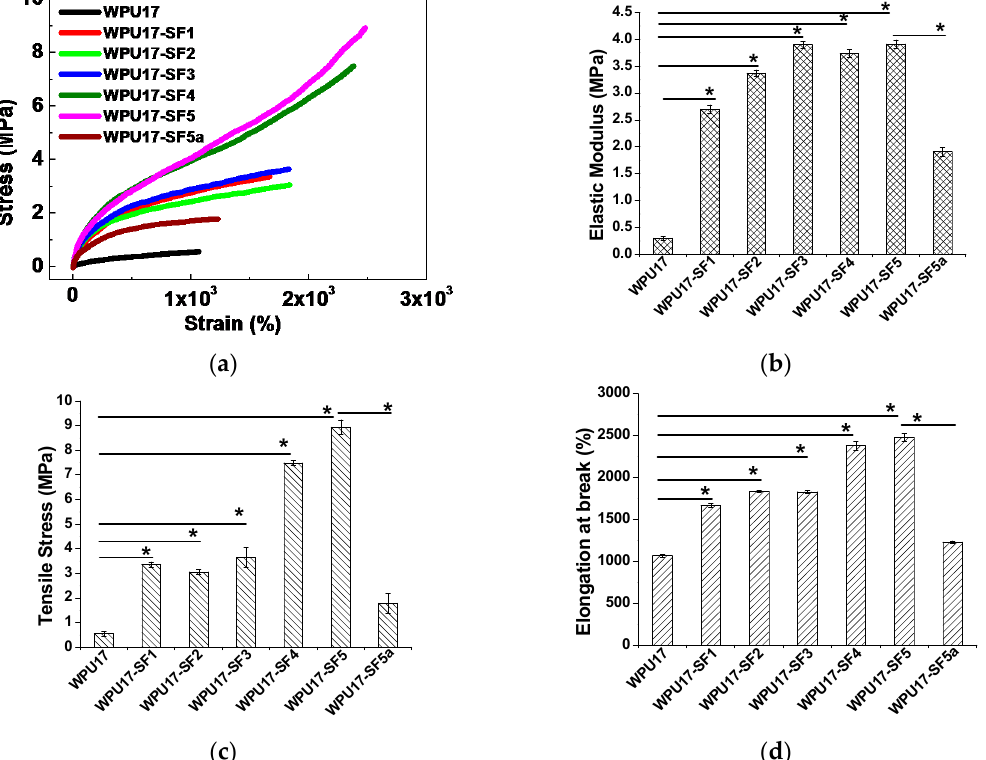
Figure 6. Uniaxial tensile mechanical properties of WPU17 and WPU17-SF films: ( a ) stress-strain curves; ( b ) elastic modulus; ( c ) tensile strength; and ( d ) elongation at break. WPU17-SF5a is the blended film with 5 wt % SF, which is prepared by blending SF into WPU17 dispersion, and is plotted for comparison. The bars represent mean ± standard deviation ( n = 3; * p < 0.05). Polymers 2016 , 8 , 94